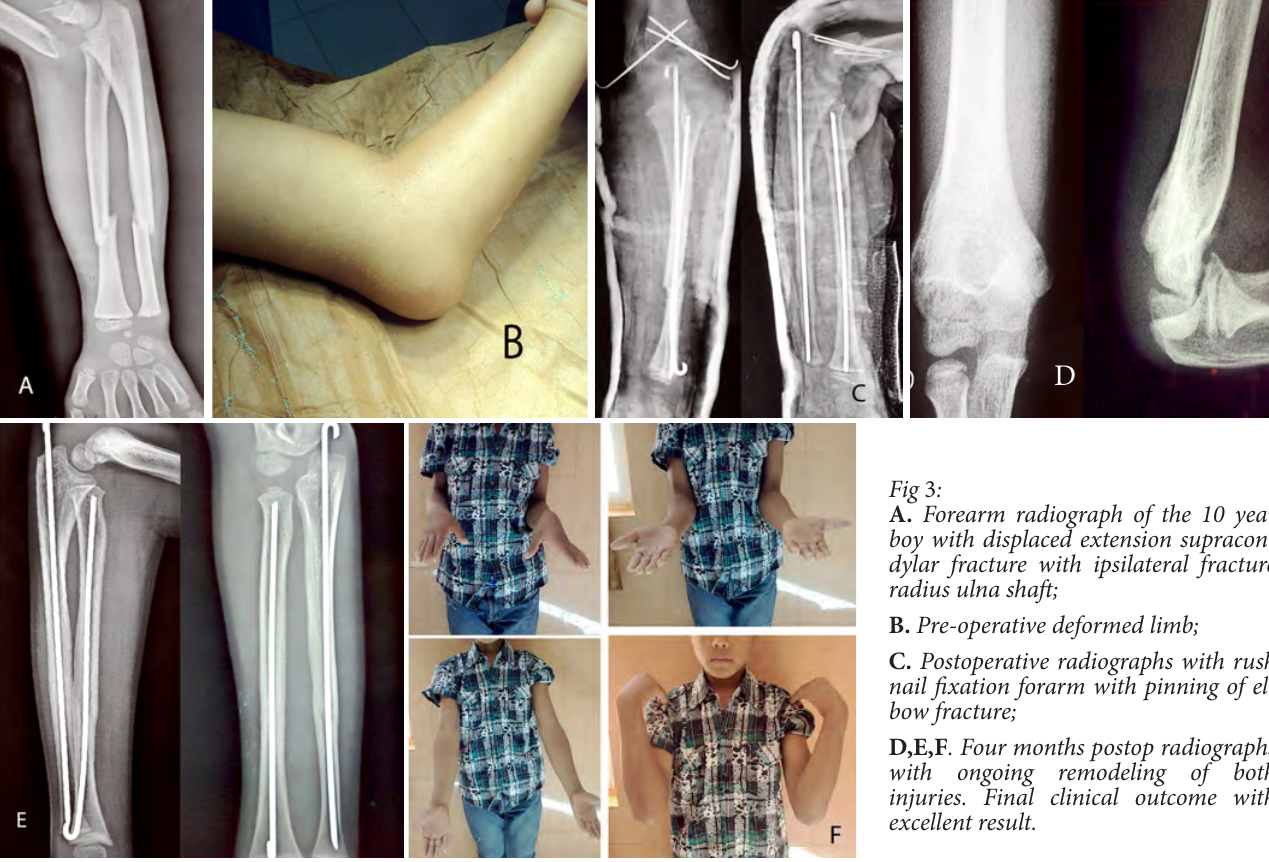
Fig 3 : A. Forearm radiograph of the 10 year boy with displaced extension supracon- dylar fracture with ipsilateral fracture radius ulna